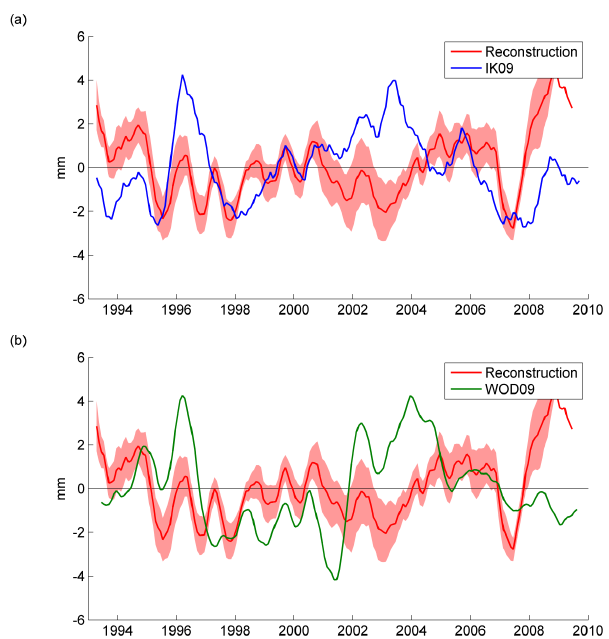
Fig. 10. Comparison of the interannual variations of the thermal Figure 10: Comparison of the interannual variations of the thermal expansion obtained from 4 this study and from (a) Ishii and Kimoto (2009) v6.12 (IK09) and (b) Levitus et al. (2009) 5 expansion obtained from this study and from (a) Ishii and Ki- (WOD09). Red shading represents discrepancies due to LSMs. Note that the reconstructed 6 moto (2009) v6.12 (IK09) and (b) Levitus et al. (2009) (WOD09). time series have been shifted by 3 months forward. 7 Red shading represents discrepancies due to LSMs. Note that the 8 reconstructed time series have been shifted by 3 months